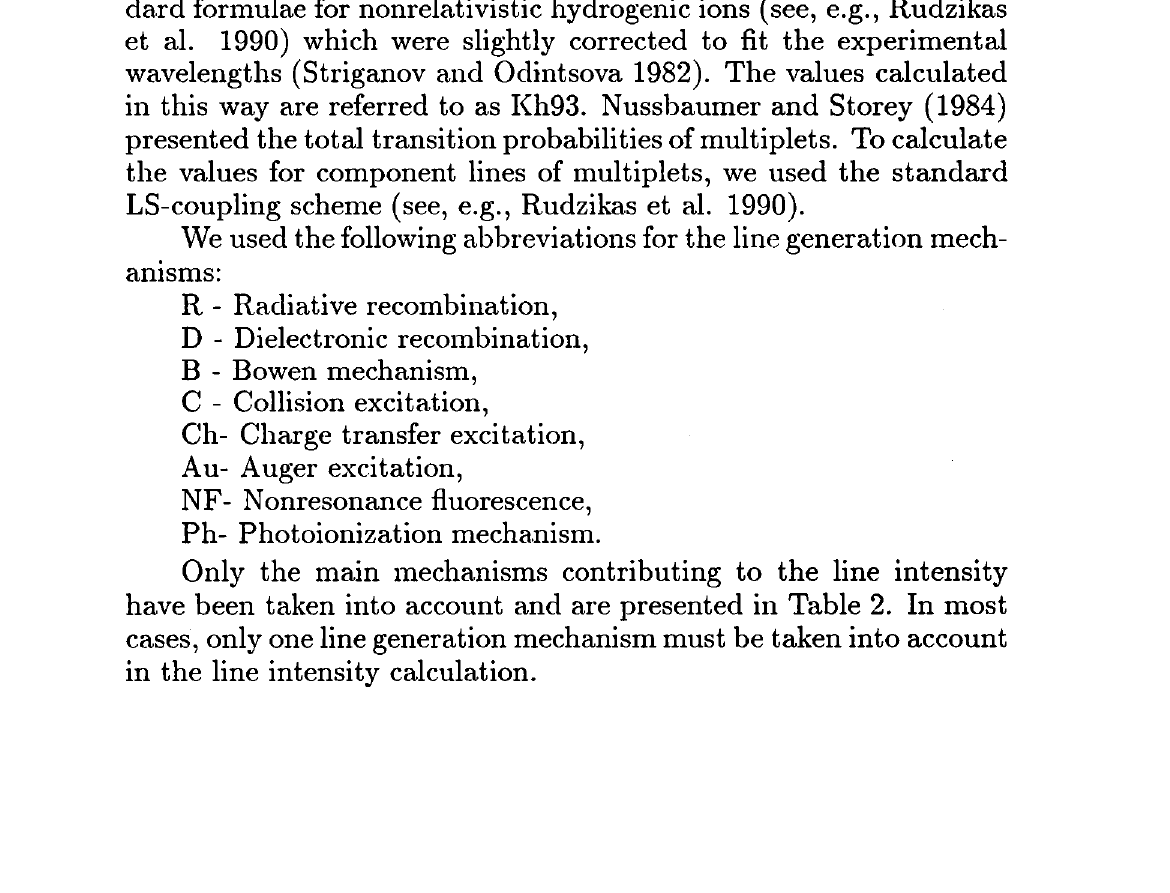
Table 2. We use notation a + b for a value of a • 10 6 . The probable line formation mechanisms are presented in column 5. The references of the used sources of the transition probabilities are given in the last